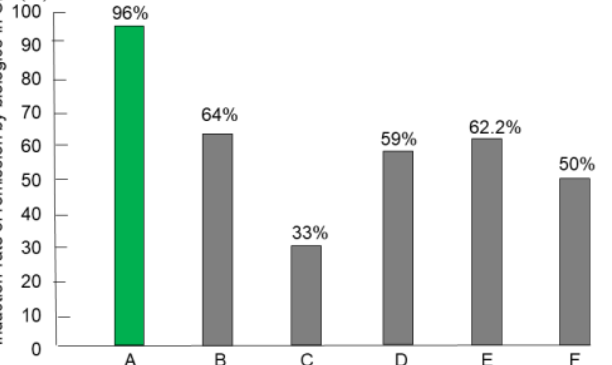
Figure 11. Induction rate of remission with biologics in patients with Crohn’s disease (CD) who were naïve to biologics. A: Infliximab and plant-based diet ( n = 44) [62] B: Infliximab and azathio- prine ( n = 65) [70] C: Infliximab and azathioprine ( n = 169) [71] D: Infliximab ( n = 41) [72] E: Ada- limumab ( n = 45) [73] F: Ustekinumab ( n = 191) [74].